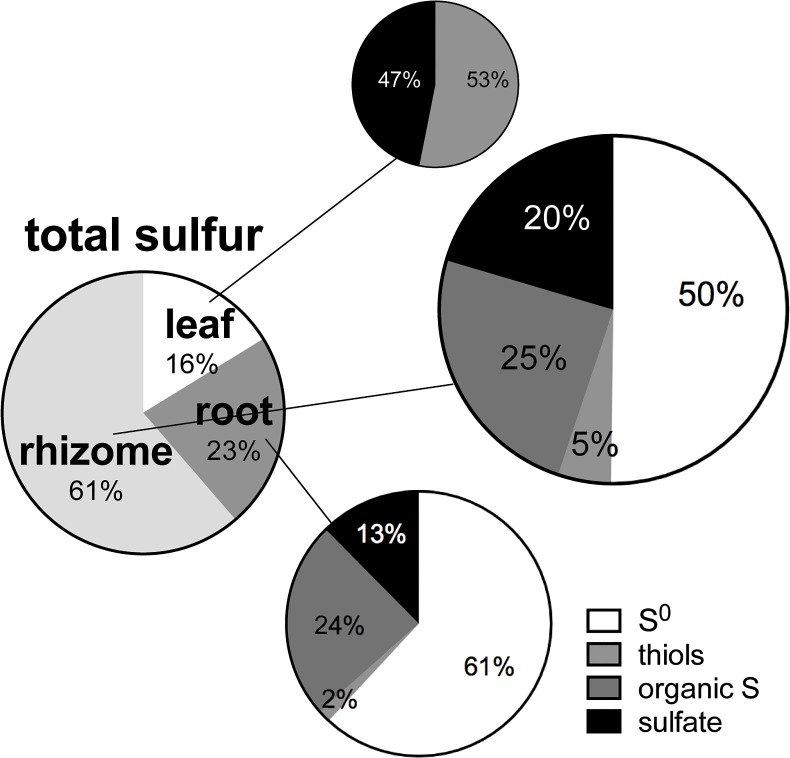
Relative net accumulation of total sulfur in Zostera marina (HS minus C) including the assemblage total sulfur composition of sulfur compounds in the different tissues (n = 6).